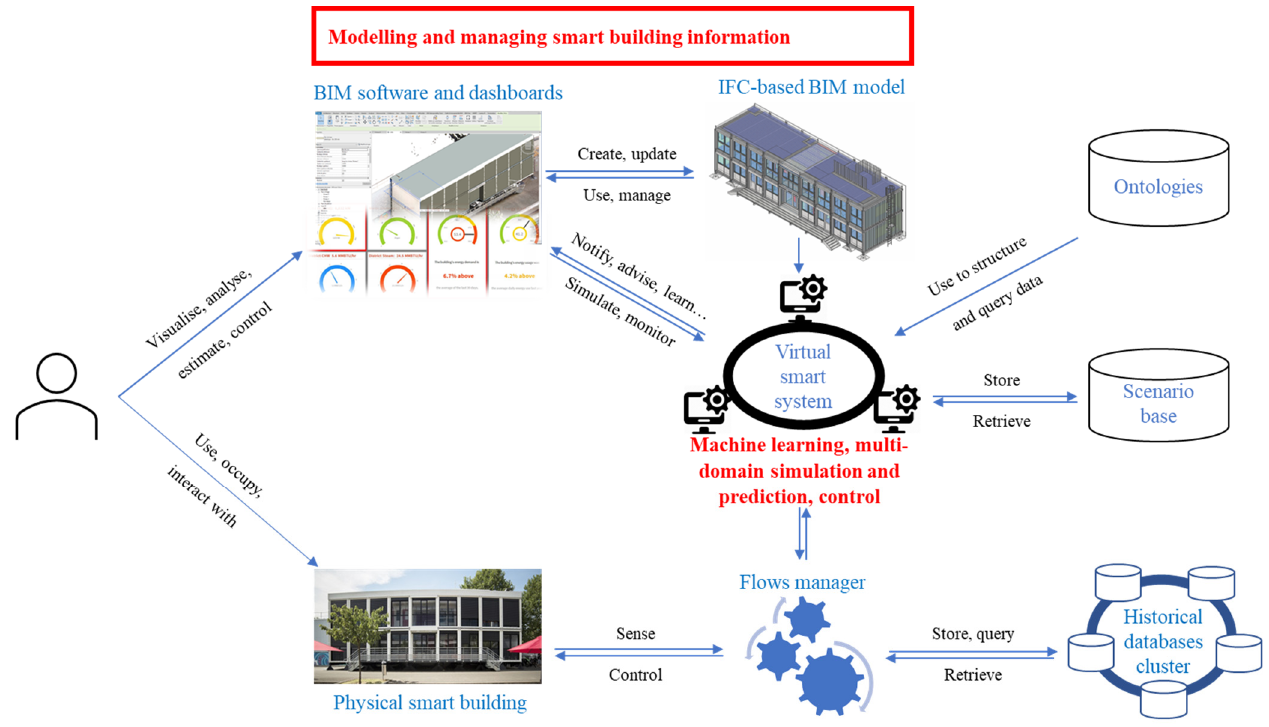
Figure 12. BIM-based workflow for N3 building energy monitoring and control.